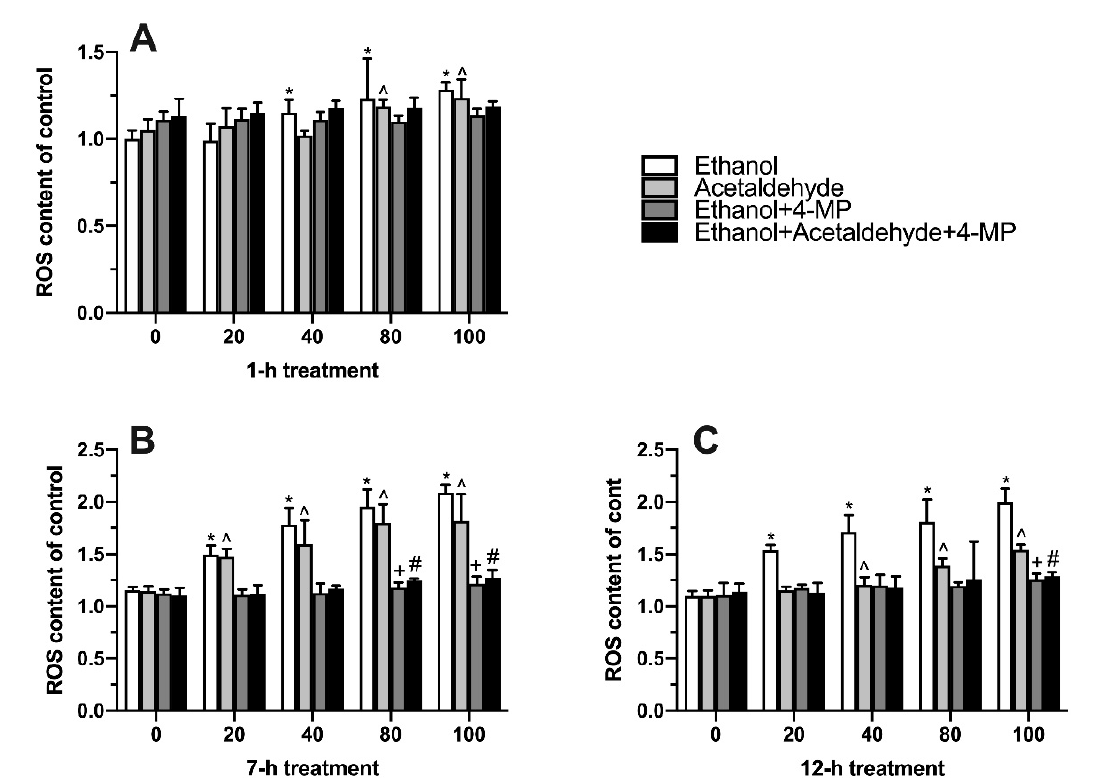
Figure 4. Effect of four different treatments on reactive oxygen species content in L02 cell lines treated for 1 h ( A ), 7 h ( B ), and 12 h ( C ). Values represent means ± SD (n ≥ 6). * p < 0.05 compared with 0 mM ethanol, ^ p < 0.05 compared with 0 µM acetaldehyde, + p < 0.05 compared with 0 mM ethanol + 500 µM 4-MP, # p < 0.05 compared with 0 mM ethanol + 0 µM acetaldehyde + 500 µM 4-MP.